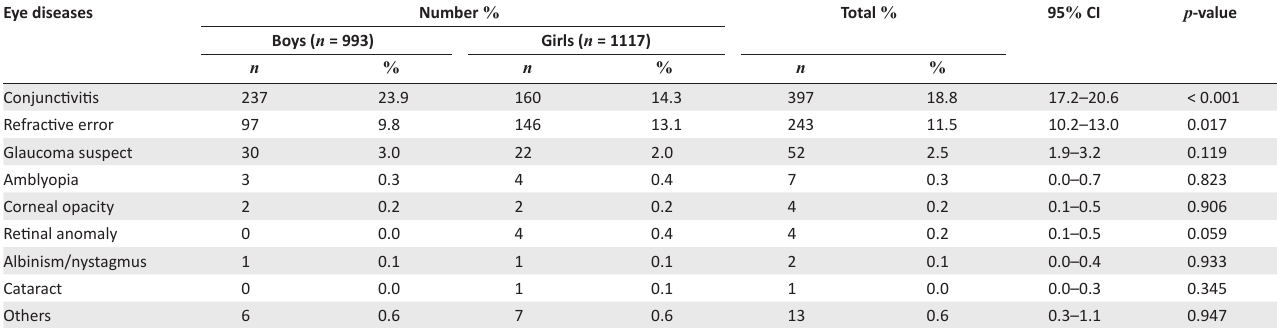
TABLE 2: Distribution of eye diseases among school children by